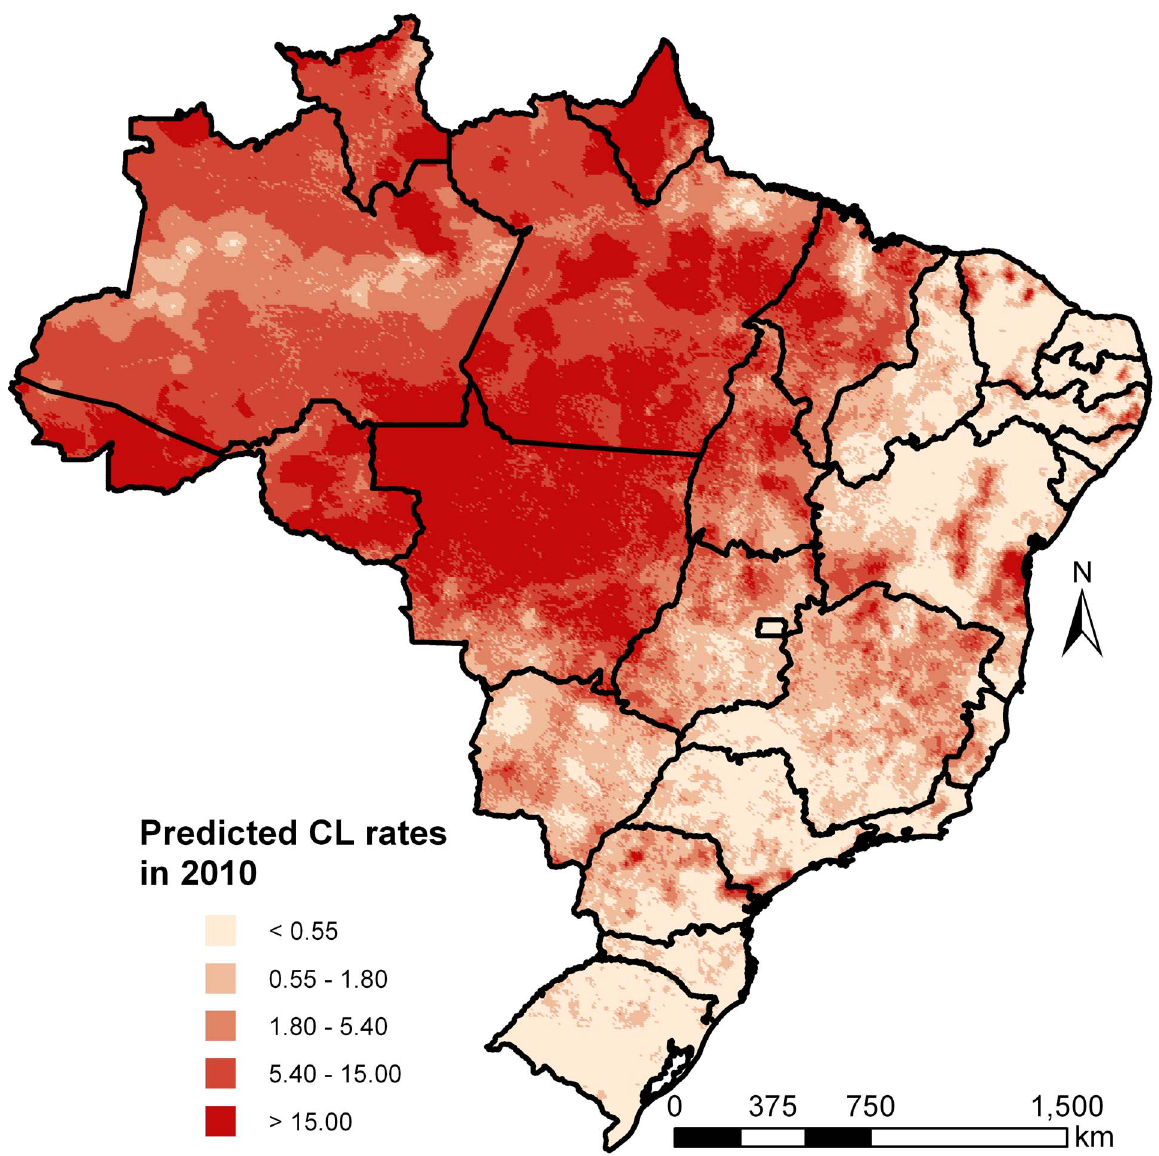
Figure 3. Geostatistical model-based predicted incidence rates per 10,000 for cutaneous leishmaniasis in Brazil in 2010.